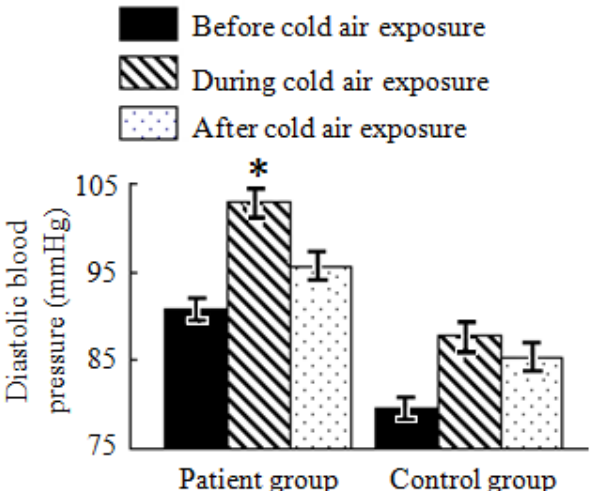
Figure 5. Average diastolic blood pressure levels in the patient and control groups during a cold air